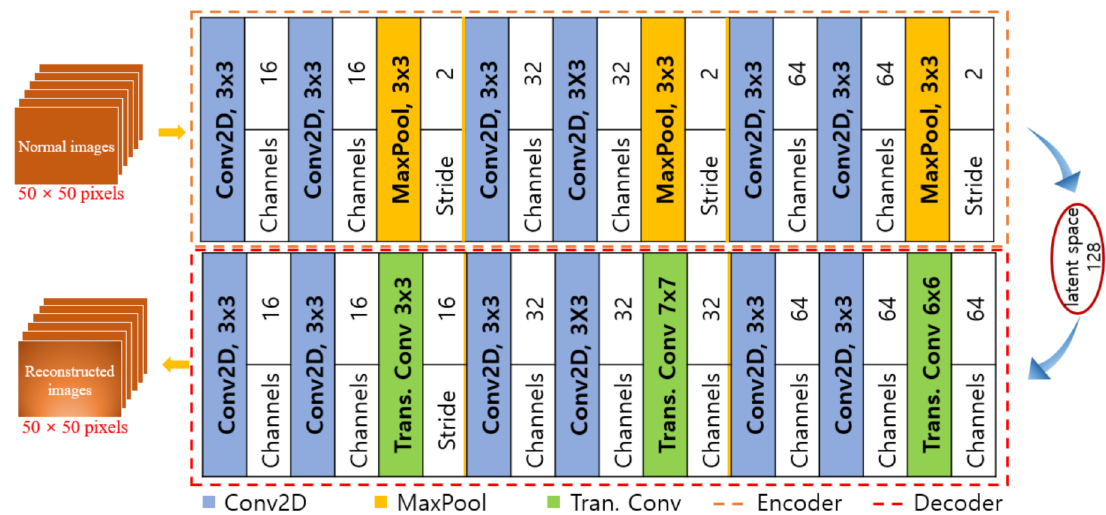
Figure 1. Model of the architecture of a convolutional autoencoder for segmentation of light emission.